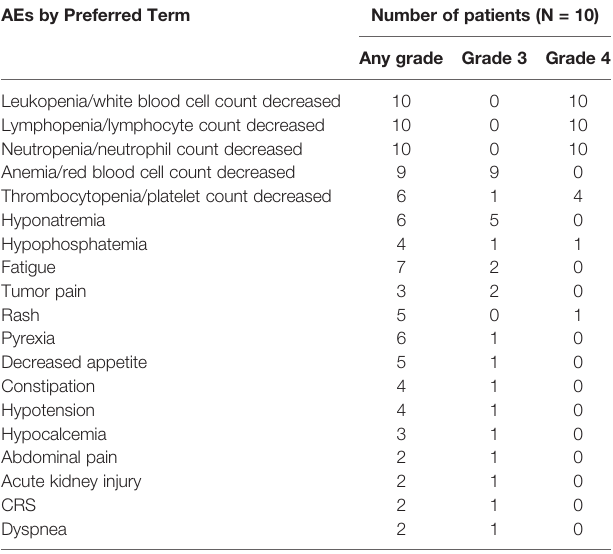
TABLE 3 | AEs in ≥ 20% of all patients of any grade and all patients of grade ≥ 3: mITT population. AEs by Preferred